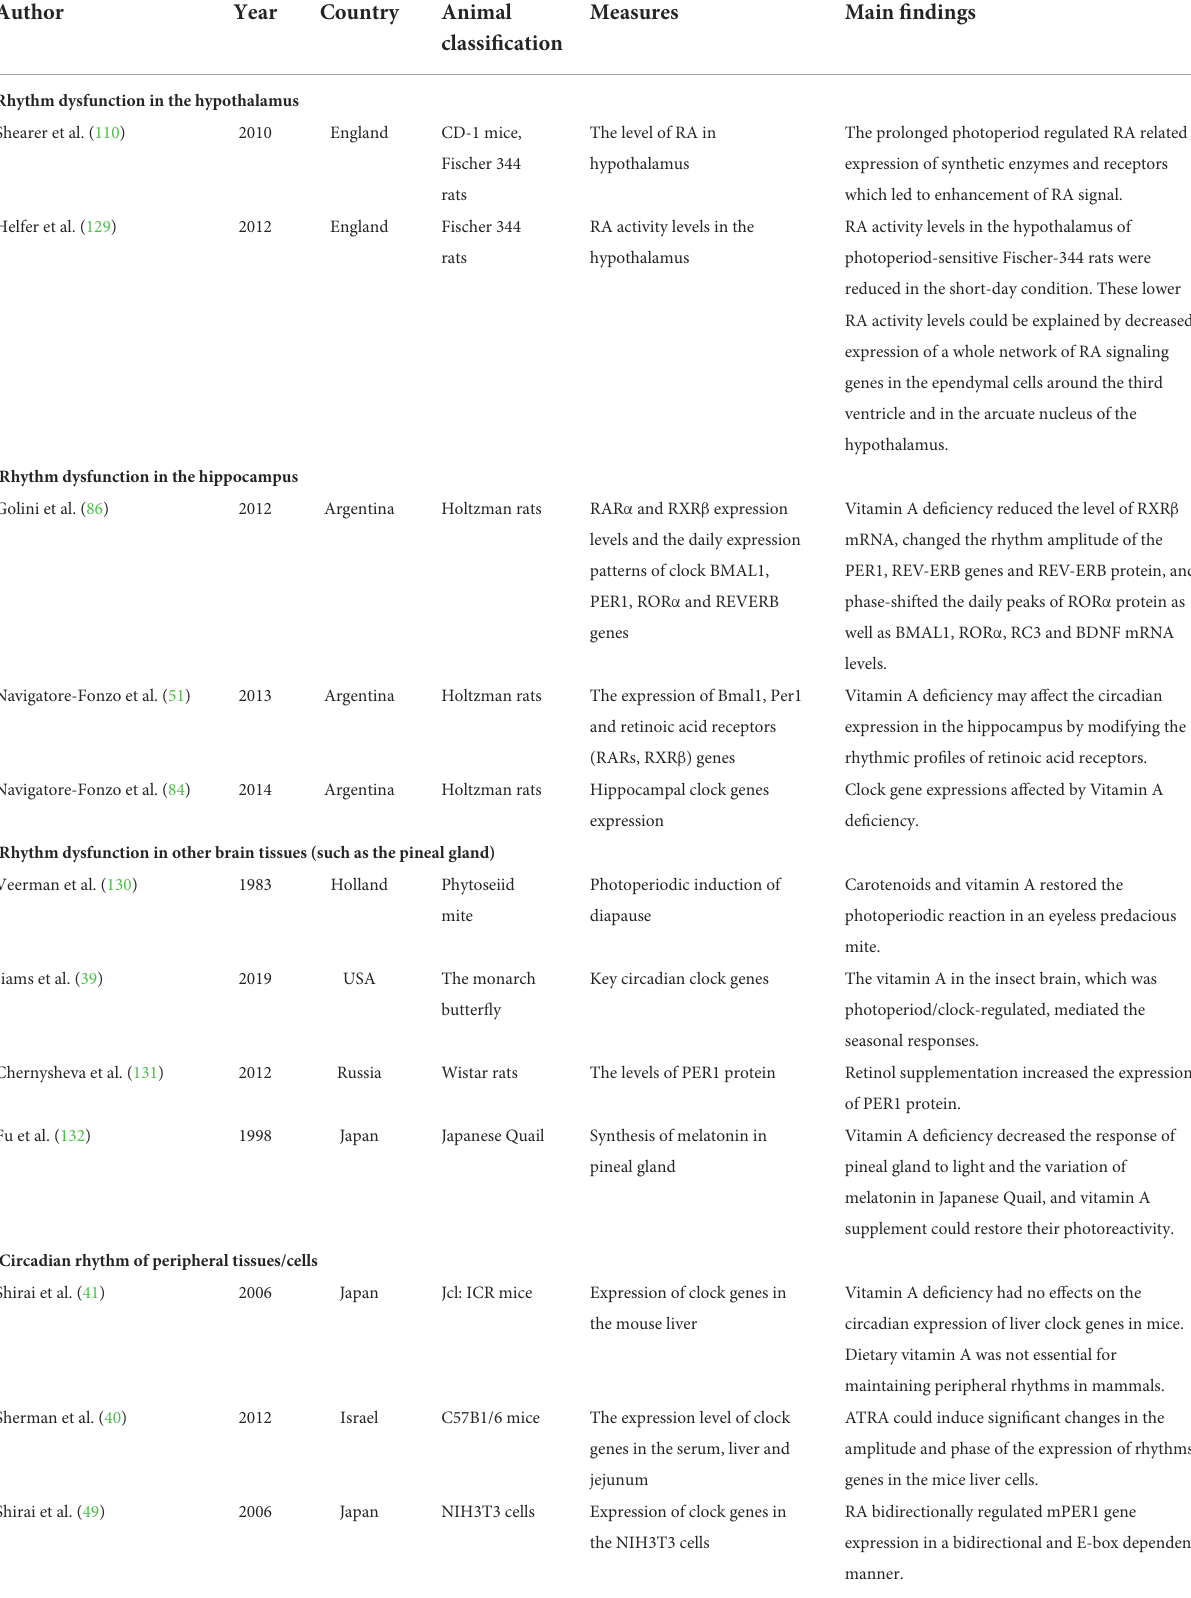
TABLE 1 Animal studies on the association of vitamin A deficiency with biological rhythm